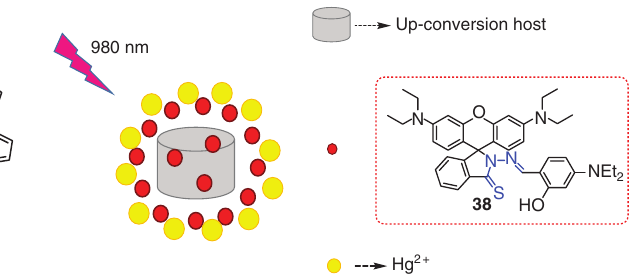
Figure 25: Recognition mechanism of probe 38 with Hg 2 + .